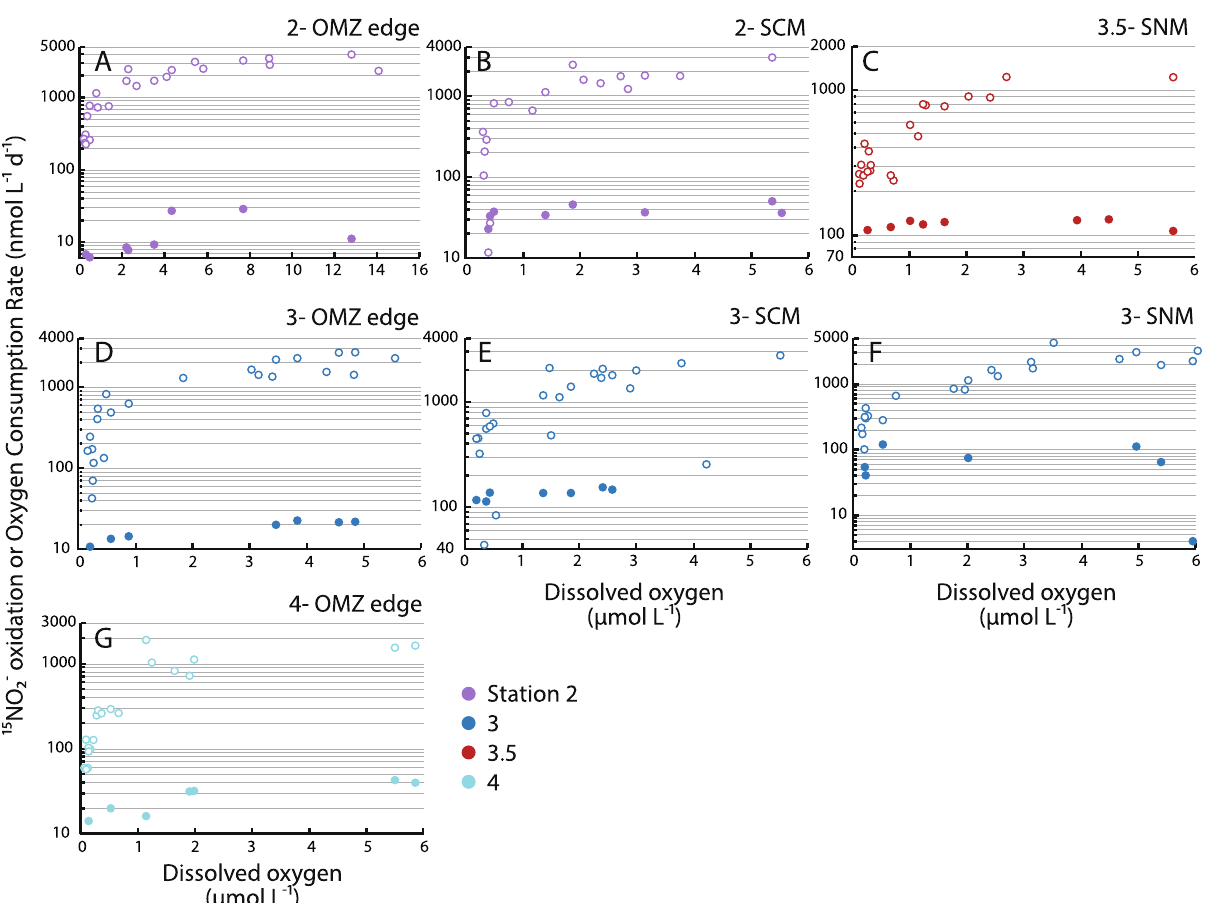
Fig. 4 Nitrite oxidation and oxygen consumption rates (OCR) in oxygen manipulation experiments. Nitrite oxidation rates ( fi lled symbols) and OCR (open symbols) are displayed as a function of average dissolved (DO) in oxygen manipulation experiments. Colors denote different stations, with panels displaying data from different experiments: A Station 2 oxygen minimum zone (OMZ) edge (20 µ M DO), B Station 2 secondary chlorophyll maximum (SCM), C Station 3.5 secondary nitrite maximum (SNM), D Station 3 OMZ edge, E Station 3 SCM, F Station 3 SNM, and G Station 4 OMZ edge. Note differences in vertical axes between experiments, and differences in the horizontal axis in panel A compared with the remaining